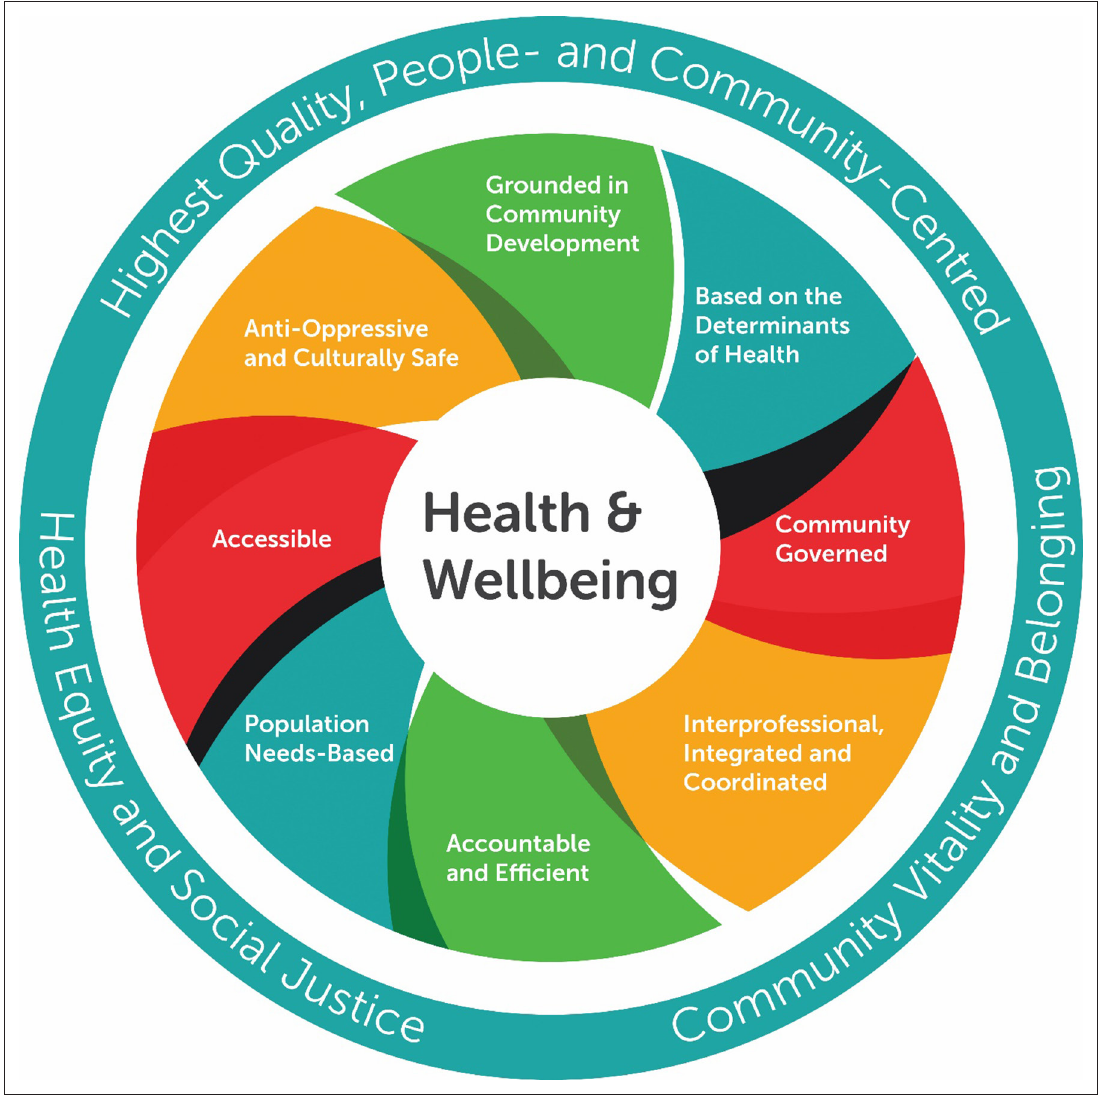
Figure 2 The Alliance for Healthier Communities' Model of Health and